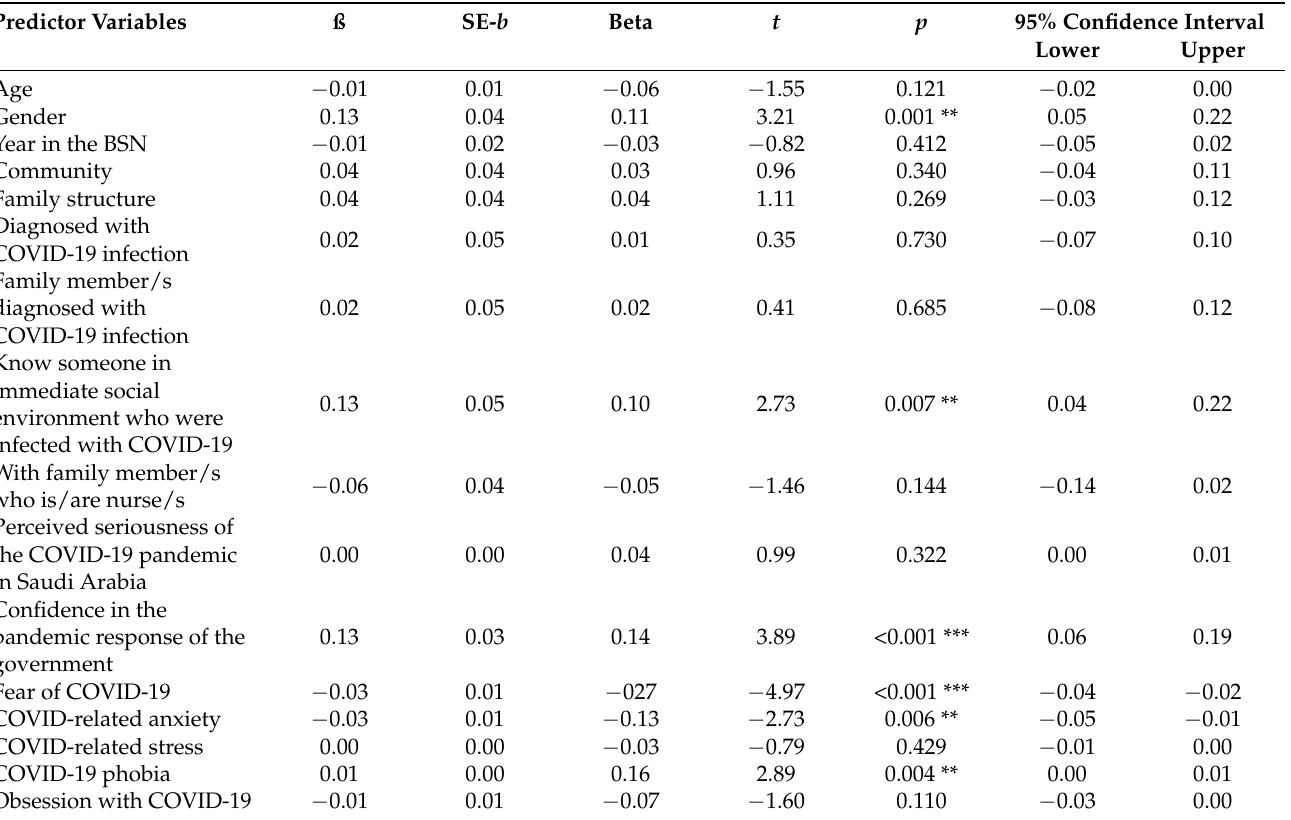
Table 3. Results of the multiple linear regression on the attitudes of students toward the nursing profession ( n =